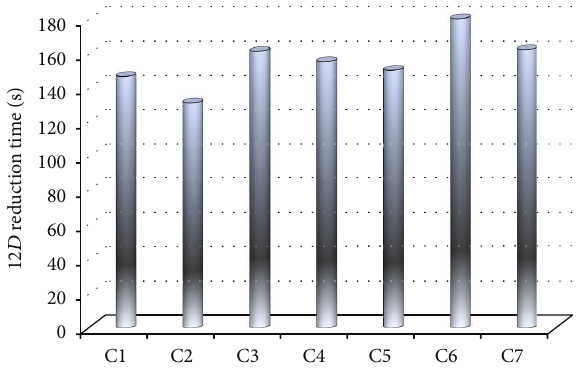
Figure5:Timerequiredtoattaina 12𝐷 reductionoftargetmicroor- ganism. C1: 𝑈 = 0 Wm −2 K −1 ; C2: 𝑈 = 0 Wm −2 K −1 and electrical